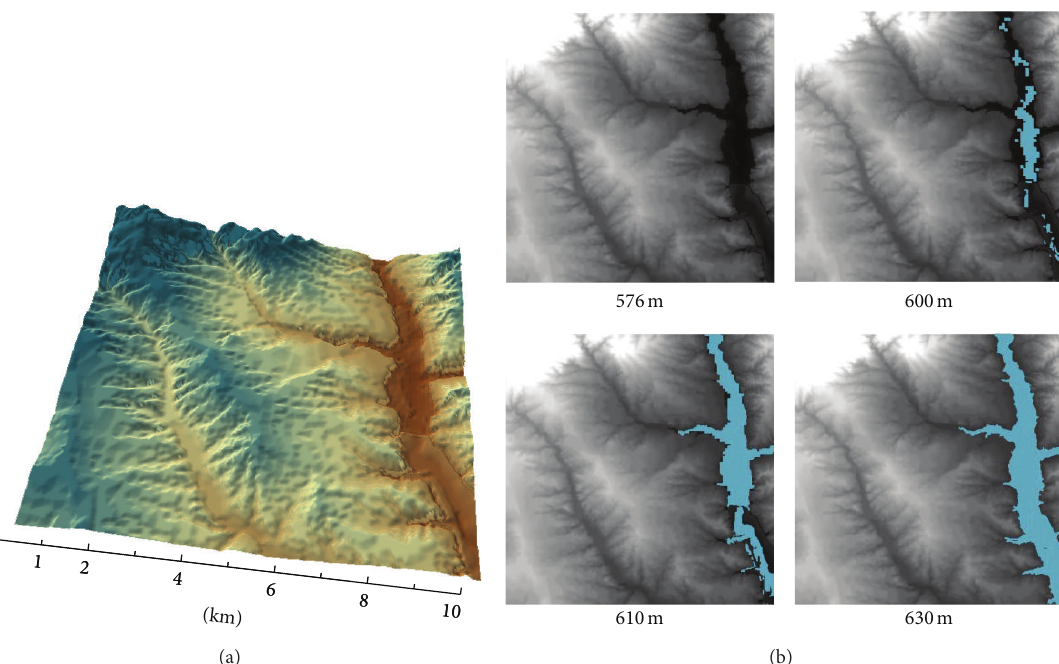
Figure 1: Visualization of DEM (1024 × 1024 data points) at the area studied (a) and the localization of the reservoir in the map at different filling levels (b) from emptiness (576 m) to full capacity (630